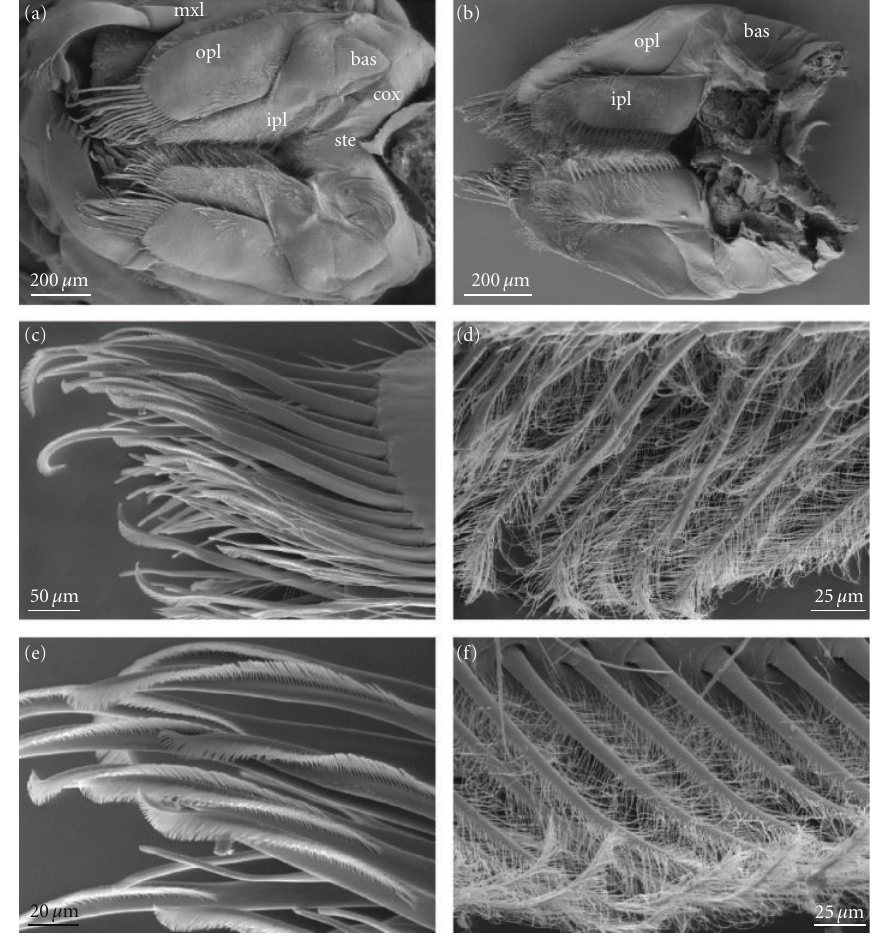
Figure 9: SEM images of maxillae of Gammarus fossarum : (a) maxillae in situ in posterior view; (b) maxillae in anterior view; (c) distal setation of outer plate of left maxilla in posterior view; (d) median setation of inner plate of left maxilla in posterior view; (e) distal setation of outer plate of left maxilla in posterior view; (f) median setation of inner plate of left maxilla in anterior view.